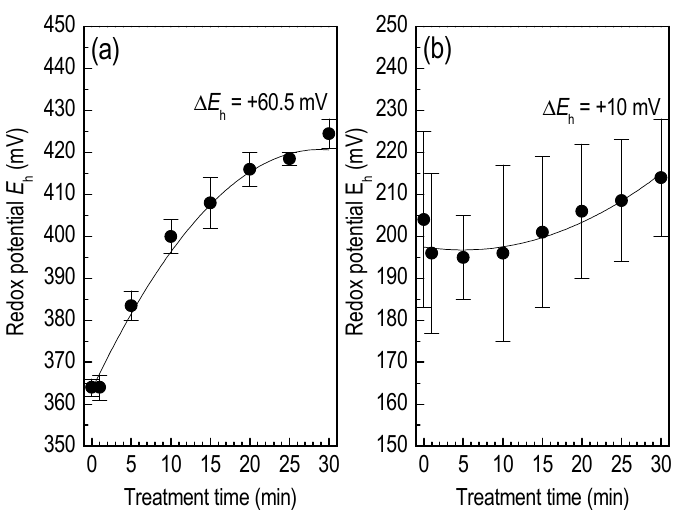
Figure 11. Redox potential evolution versus the treatment time in the case of ( a ) DDW and ( b ) PBS. Mean values and standard deviations are calculated from two series of experiments carried out on different dates. Operating conditions: 11 kV pp , 17.5 kHz, and 1.5 slm.